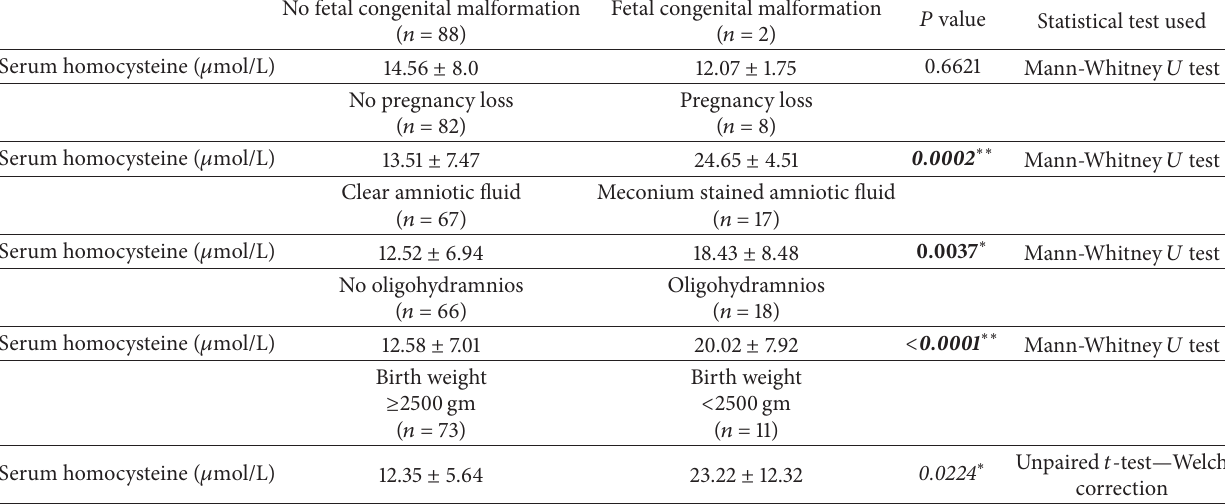
Table 4: Homocysteine levels with reference to fetal outcome of present